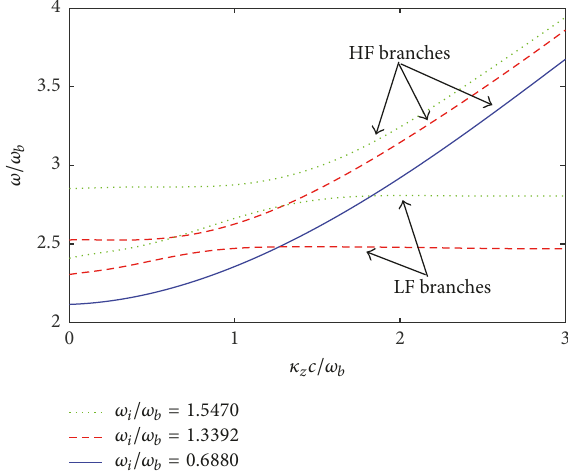
Figure 10: The effect of the ratio 𝑎/𝑏 on the dispersion curves of the TM 01 modes for strong ion channel with 𝜔 𝛽 = 1.6202 . The outer radius of the annular beam is taken as 𝑏 = 0.4𝑅 and 𝑎/𝑏 = 0 represents the solid beam case.